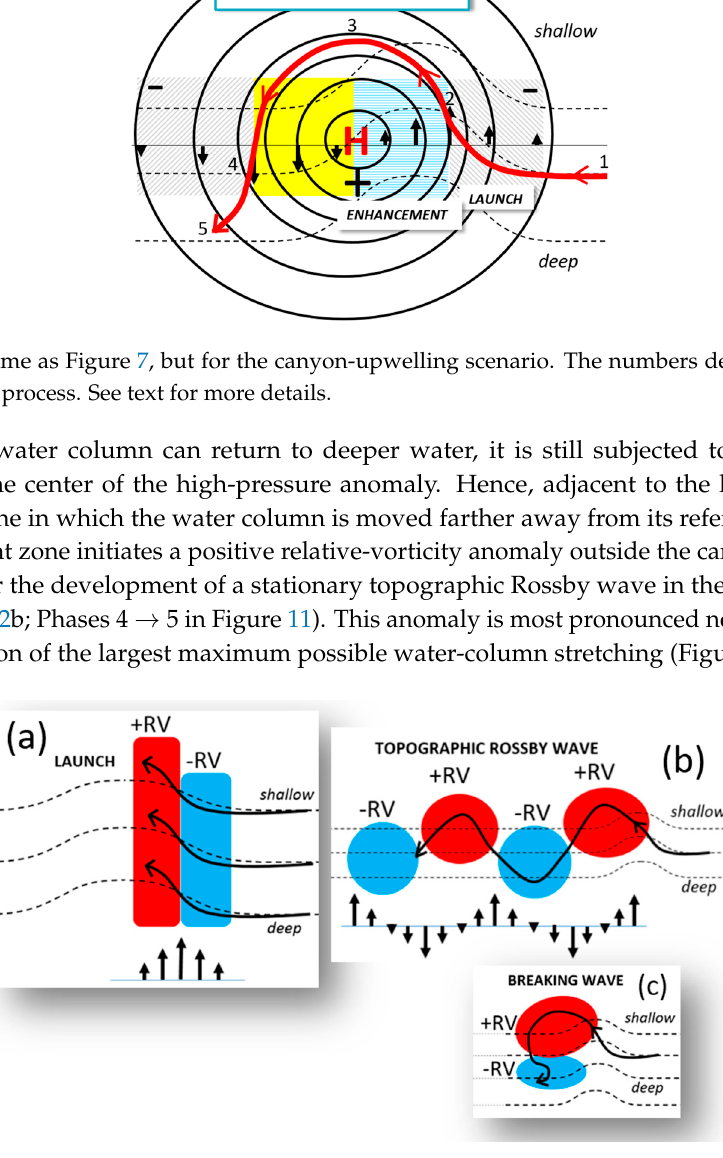
Figure 12. Schematics of different phases of the canyon-upwelling process: ( a ) the launch phase (Phases 1 → 2 in Figure 11); ( b ) the initiation of a topographic Rossby wave in the lee of the canyon; and ( c ) the possibility of breaking waves. Dashed lines are bathymetric contours. Long arrows indicate flow trajectories. Colored regions indicate zones of positive or negative relative vorticity (RV). Small arrows denote the structure of the cross-shelf flow. See text for further discussion.